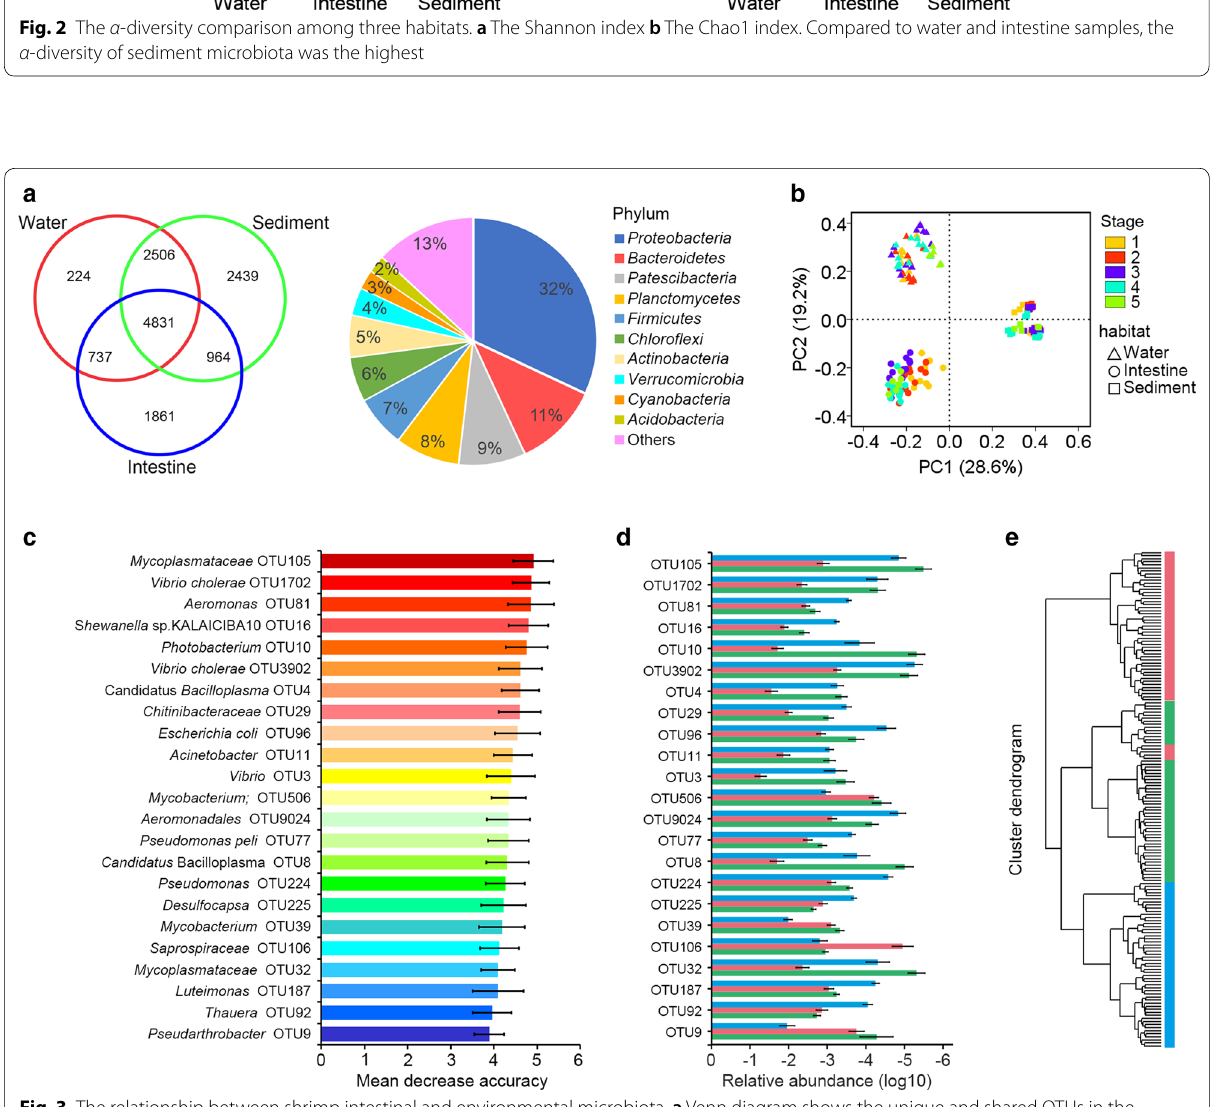
Fig. 3 The relationship between shrimp intestinal and environmental microbiota. a Venn diagram shows the unique and shared OTUs in the different habitats. the shared OTUs majorly belonged to Proteobacteria and Bacteroidetes phylum. b PCoA of microbial communities based on the 16S rRNA sequencing profiles. Samples were clustered into three groups by PCoA based on Bray–Curtis distance, indicating that the microbial structure differed significantly among three habitats. c Classification of the OTU markers for the three habitats. A total of 23 OTU markers were selected as the optimal marker set by a ten-fold CV-error curve. d The relative abundance of the OTU markers at each group. e UPGMA clustering based on the 23 markers revealed that the microbial composition of each group was clearly